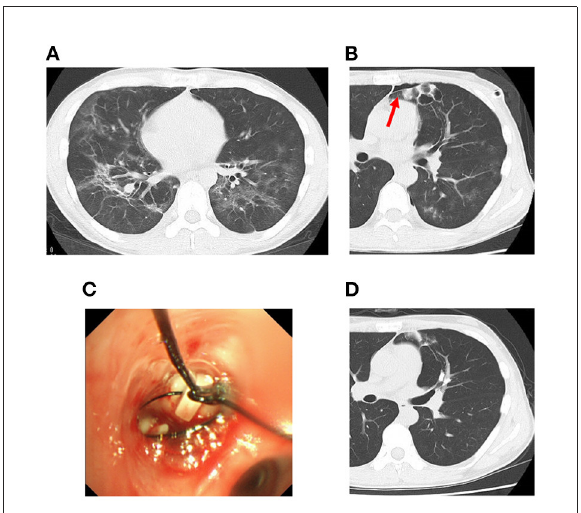
FIGURE1 Chest computed tomography (CT) scan on admission (A) , at 11 days (B) , and after bronchial occlusion with a endobronchial Watanabe spigot (EWS) (D) , and EWS (C) . CT scan of the chest showing diffuse ground glass opacity on admission (A) . CT scan of the chest showing cysts clustered on the peripheral side of the left B4 at 11 days (B) . EWS shown being implanted in left